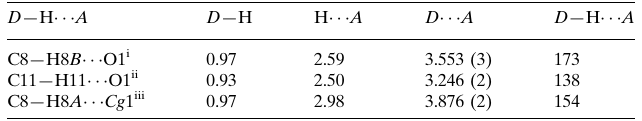
Hydrogen-bond geometry (A˚ , (cid:1)